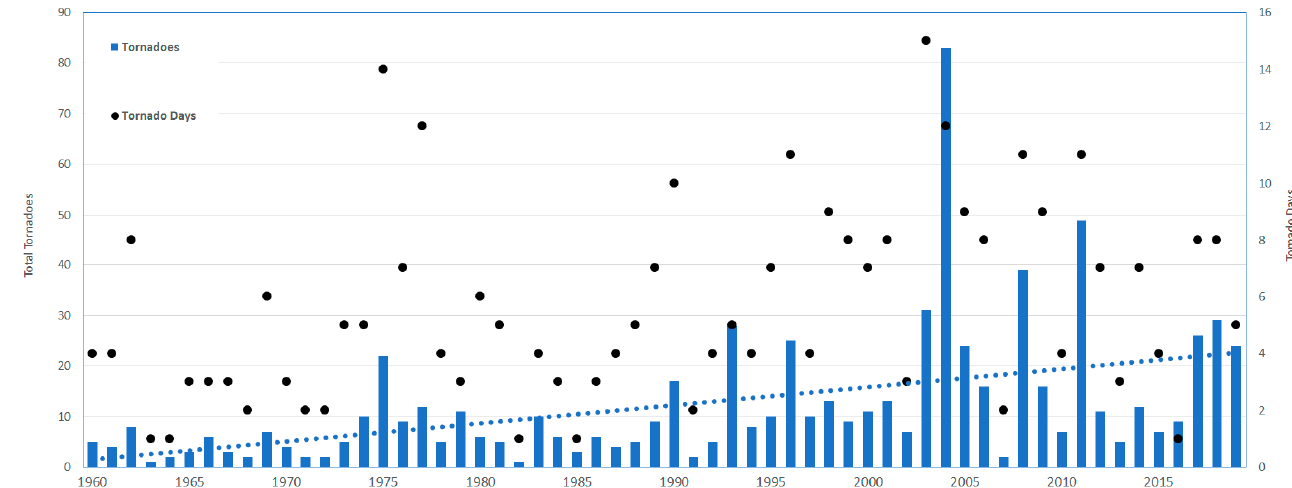
Figure 3. Annual tornadoes and tornado days in the Commonwealth of Virginia. The blue-dotted line represents the long-term, upward trend in tornadoes (1960–2019).